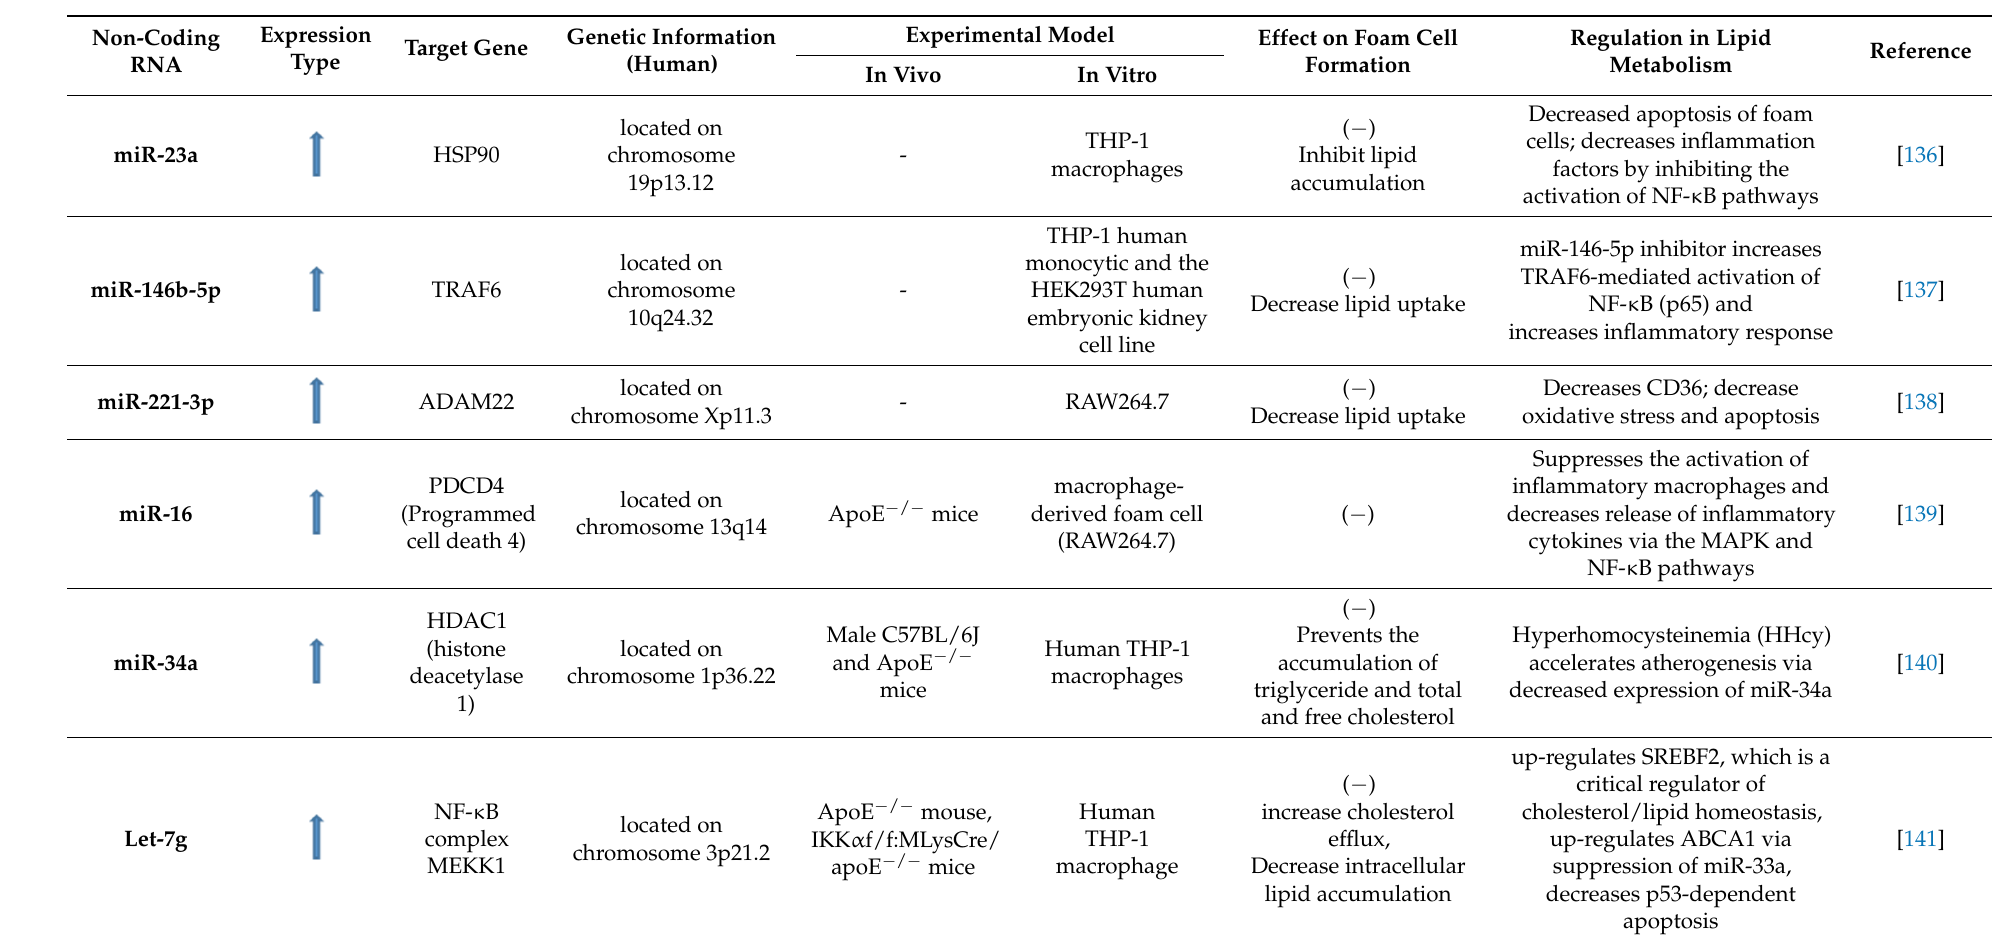
Table 1. Non-coding RNAs that stimulate foam cell formation/function.